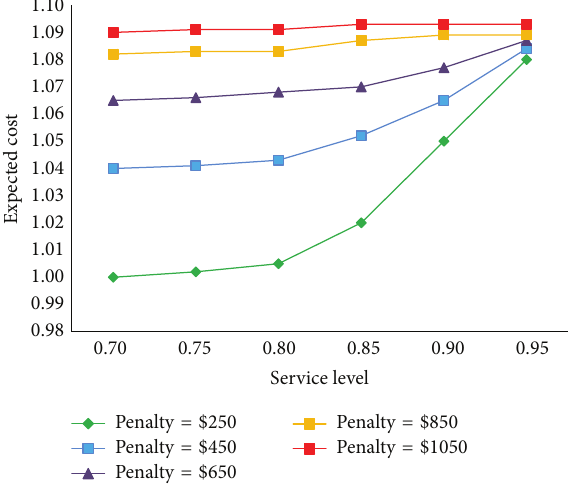
Figure 5: Relative cost against service level at all sites ( 𝛼 system ) as the penalty cost increases under MP policy, problem set 3.